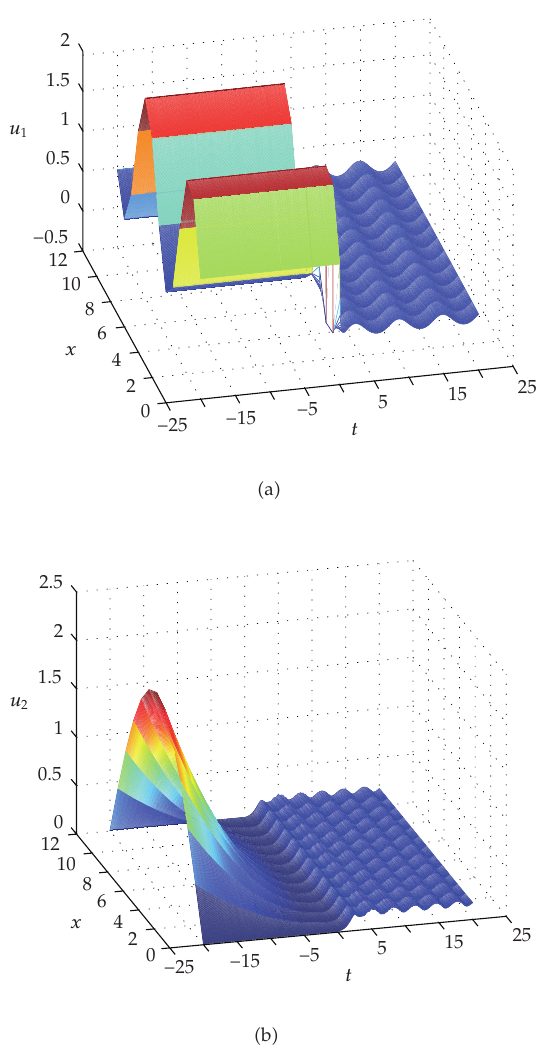
Figure 2: Numerical simulation of Example